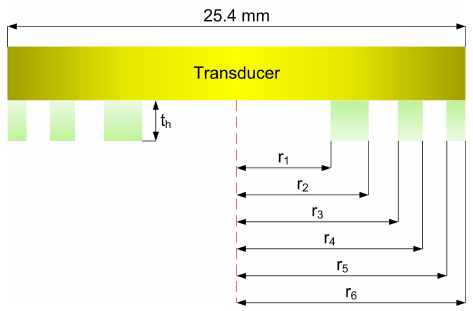
Figure 2. Building scheme of Phase-Reversal Fresnel Zone